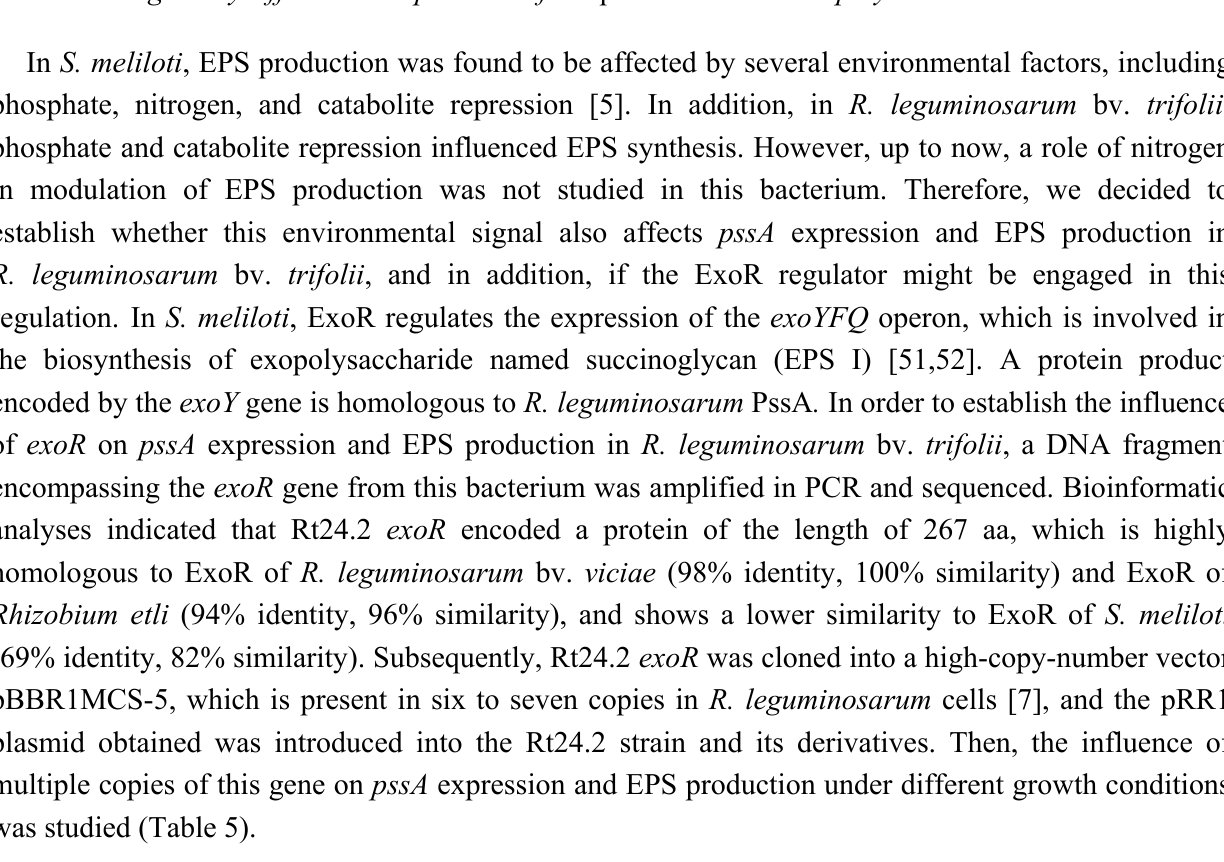
5. The influence of multiple exoR copies on pssA-lacZ expression in different Rhizobium leguminosarum bv. trifolii 24.2 derivatives under low- and high-ammonium